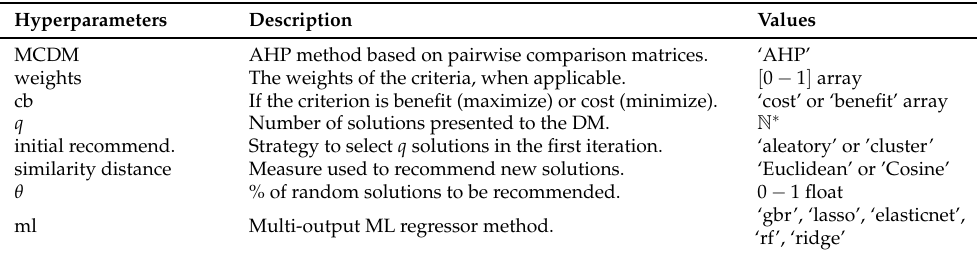
Table 2. Description of the parameters and hyperparameters of the proposed approach, and their expected